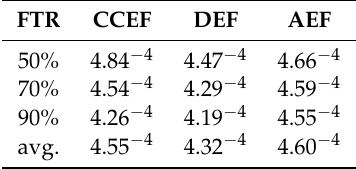
Figure 7. Energy efficiency (FTR 50, 70, and 90% at first cut-off (FCO)). Table 3. Energy efficiency comparison